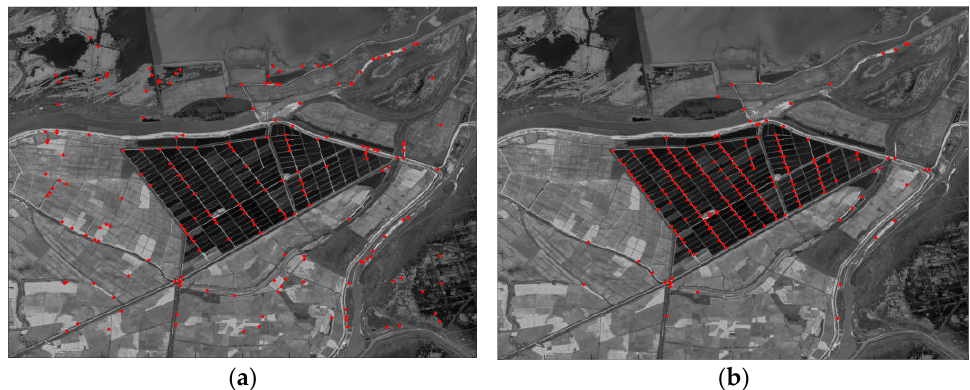
Figure 2. Comparison of corner extraction results. ( a ) Block – Harris extraction result; ( b ) Harris extraction result.